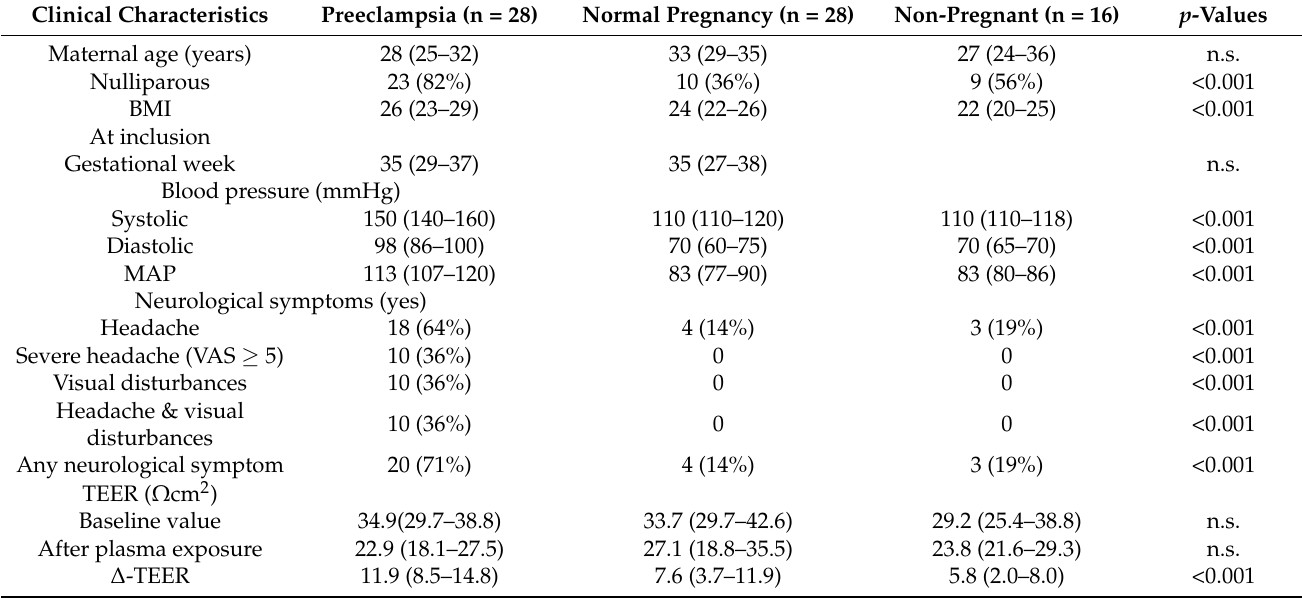
Table 1. Clinical characteristics of the study population.